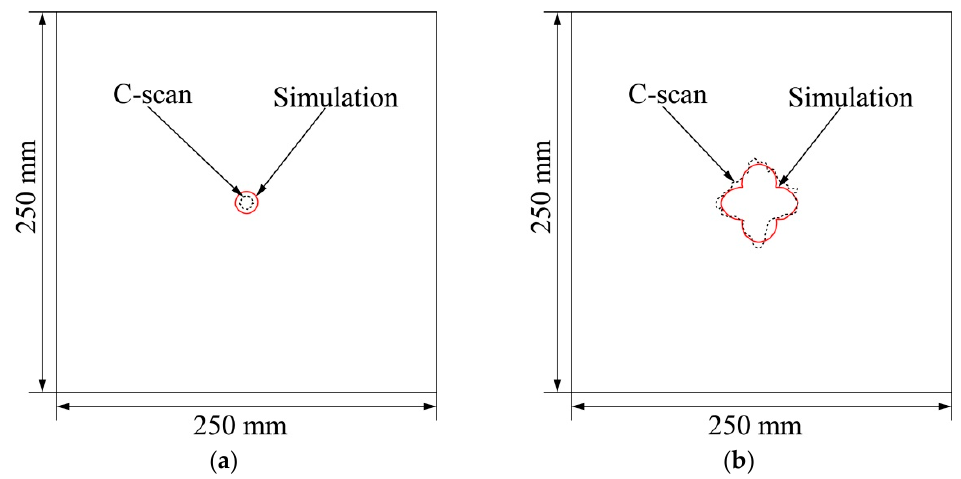
Figure 9. Cross-sectional temperature profiles of the fastener hole under different simulation models and different lightning current components: component C in the ( a1 ) conduction current + heat flux model, ( a2 ) conduction current model, and ( a3 ) heat flux model; component D in the ( b1 ) conduction current + heat flux model, ( b2 ) conduction current model, and ( b3 ) heat flux model.